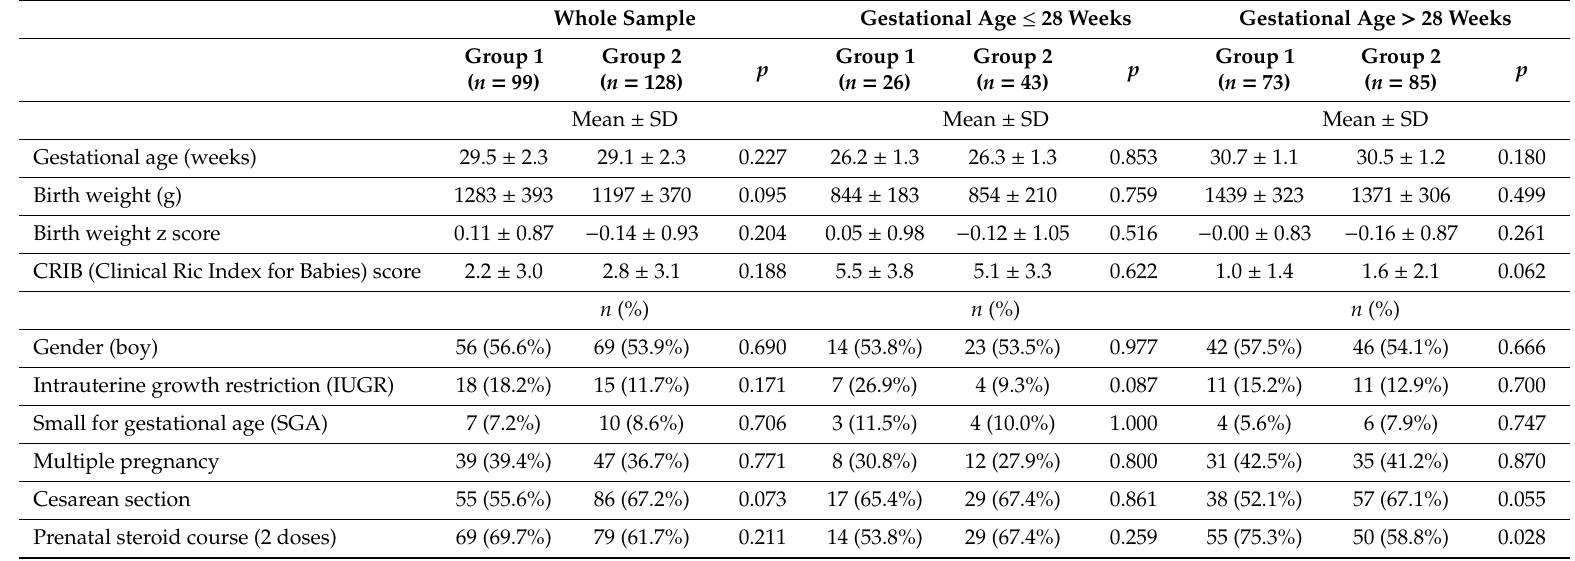
Table 1. Comparison of basal characteristics of the patients from groups 1 and 2.